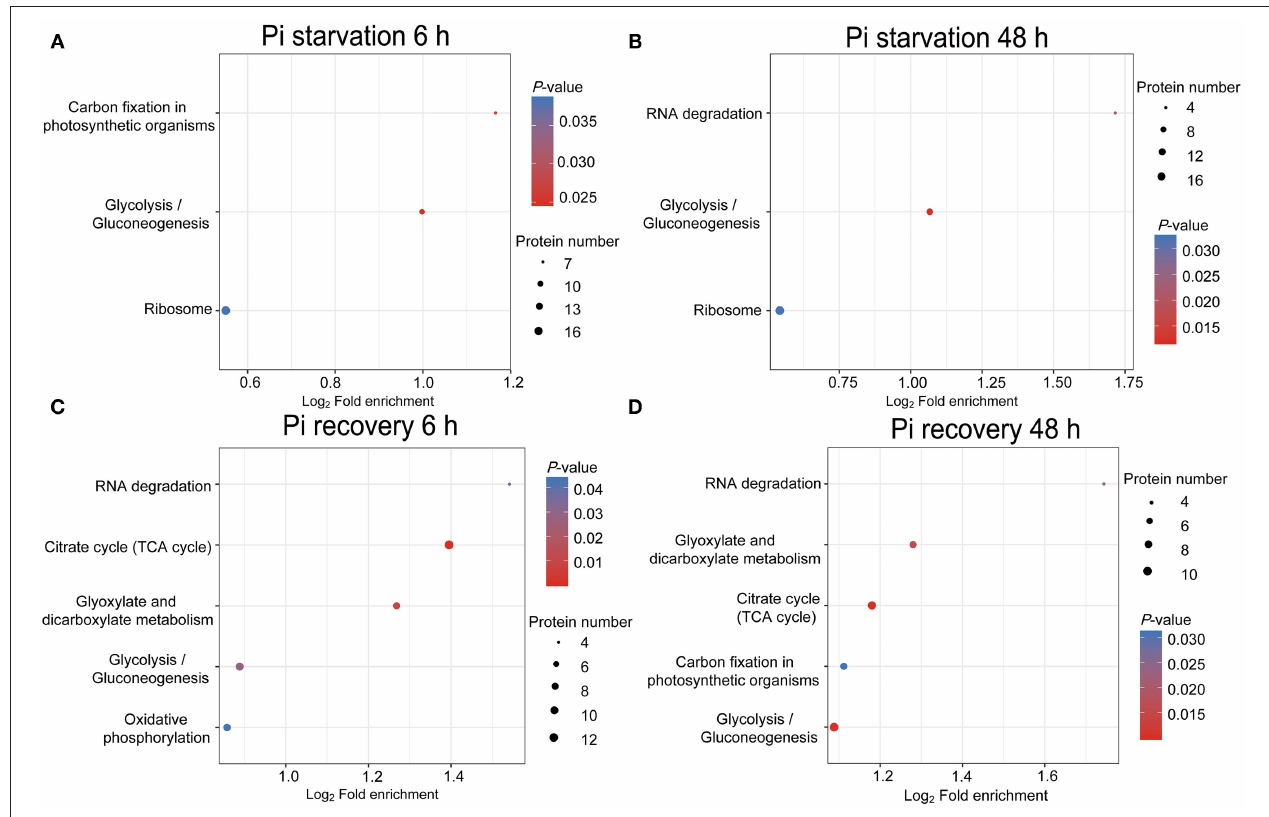
FIGURE 5 | KEGG pathway enrichment analysis of DFASPs in roots under Pi starvation at 6h (A) and 48h (B) and Pi recovery at 6h (C) and 48h (D) .